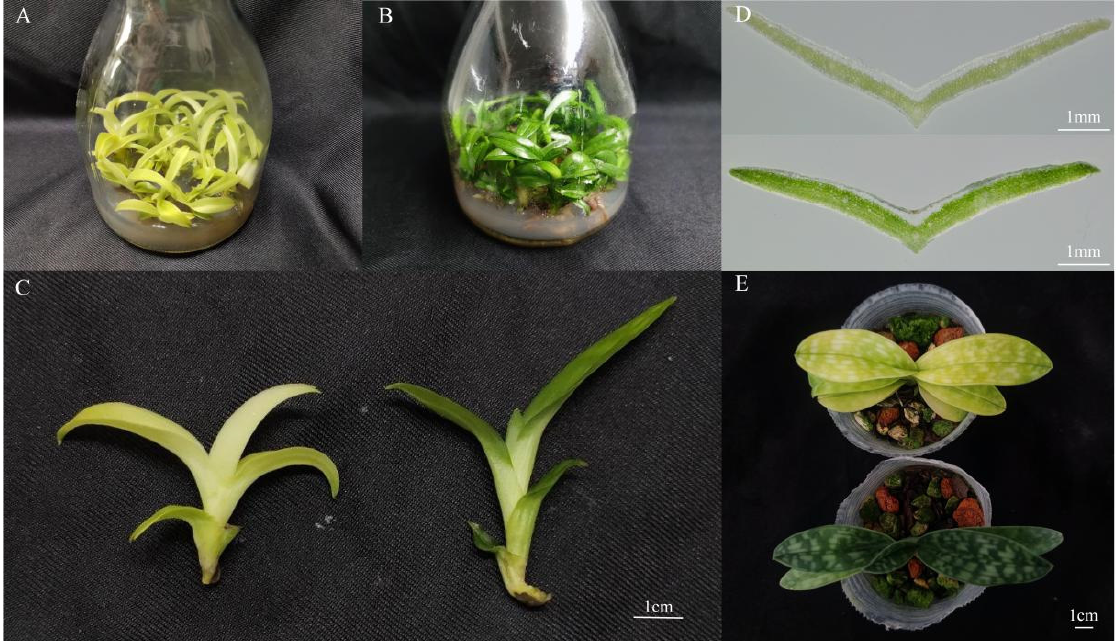
Figure 1. Phenotype of P. SCBG COP15 and the yellow mutant. ( A ) Phenotype of P. SCBG COP15. ( B ) Phenotype of the yellow mutant. ( C ) One year old seedling of P. SCBG COP15 (right) compared with the yellow leaf variety (left). ( D ) The anatomical distribution of pigments in P. SCBG COP15 (below) and the yellow mutant leaves (above). ( E ) Seedlings of the P. SCBG COP15 (below) and the yellow leaf variety (above) growing in the Orchid greenhouse.